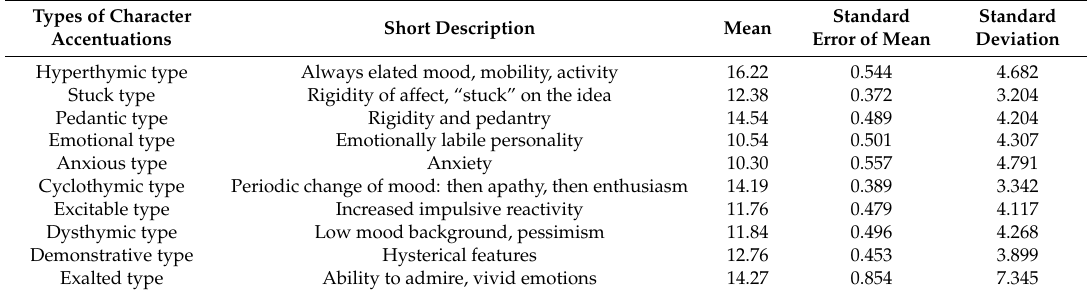
Table 2. Severity of types of character accentuations of